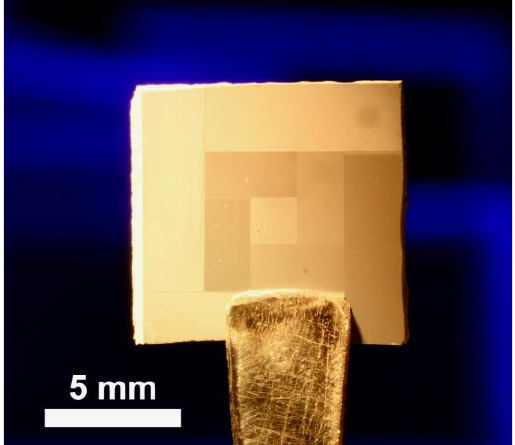
Figure 12. Photograph of a ZnO-nanostructure overgrown Si-wafer. The various shades correspond to different ZnO nanostructures grown on different laser-generated Au-catalysts.